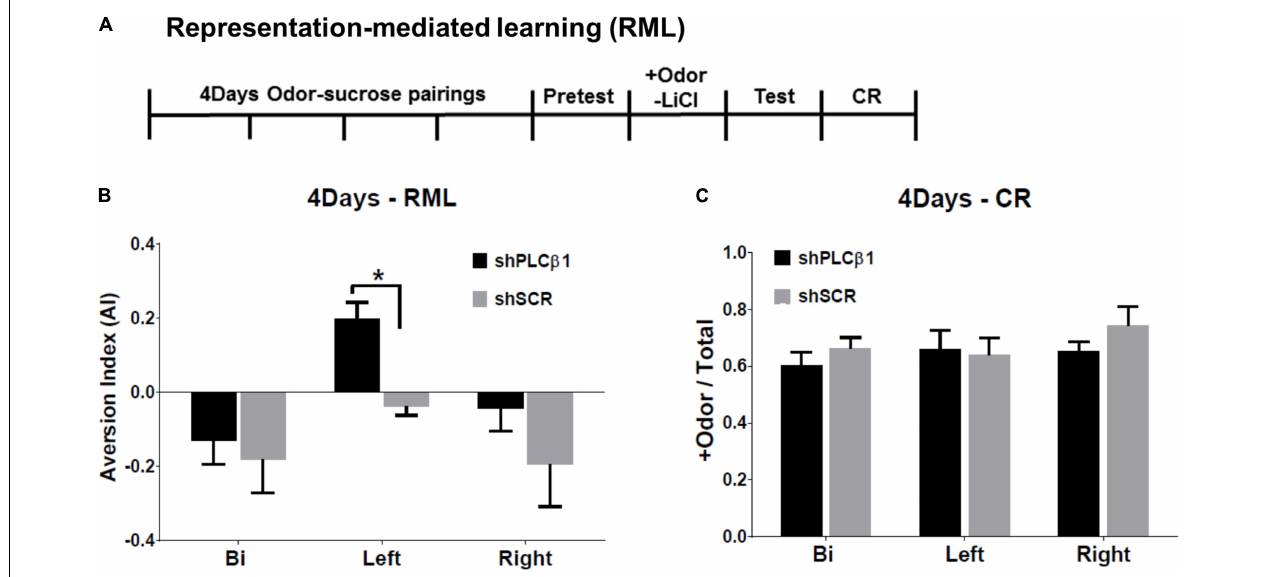
FIGURE 4 | Effects of local knockdown of Phospholipase C β 1 (PLC β 1) in the bilateral, left, or right medial prefrontal cortex (mPFC) on mediated learning sensitivity after extended training (4Days). (A) Representation-mediated learning (RML) paradigm took place over 8 days. +Odor → sugar conditioning was given for 4 days. On day 5, a baseline sugar consumption was measured. On day 6, +Odor → nausea pairing was given. A post-nausea sugar consumption was measured on day 7 and conditioned response (CR) was tested on day 8. (B) Aversion index (AI) values for the mice injected, bilaterally (Bi), to the left (Left), or right (Right) side of mPFC, with shPLC β 1 (black) or shSCR (gray) virus. (C) CR, the relative time spent in food cup in response to +Odor, tested after RML test for the same groups shown in panel (B) . Numbers of mice ( N ): (B) (Bi shPLC β 1, N = 8; Bi shSCR, N = 6; Left shPLC β 1, N = 10; Left shSCR, N = 12; Right shPLC β 1, N = 12; Right shSCR, N = 9), (C)